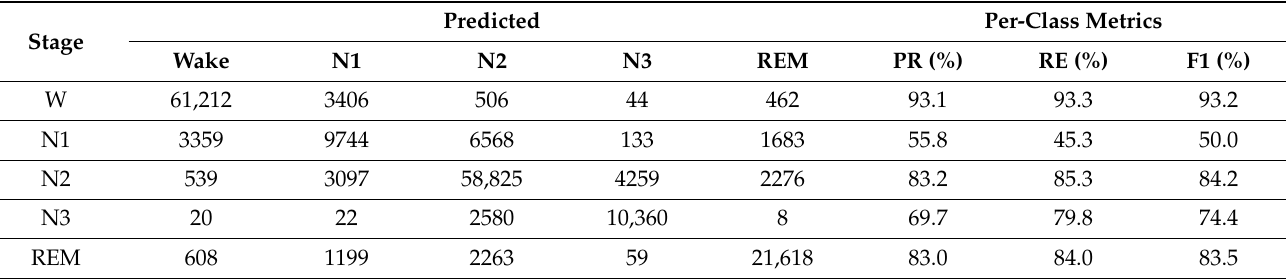
Table 5. Confusion matrix of Sleep-EDFX-78 dataset.